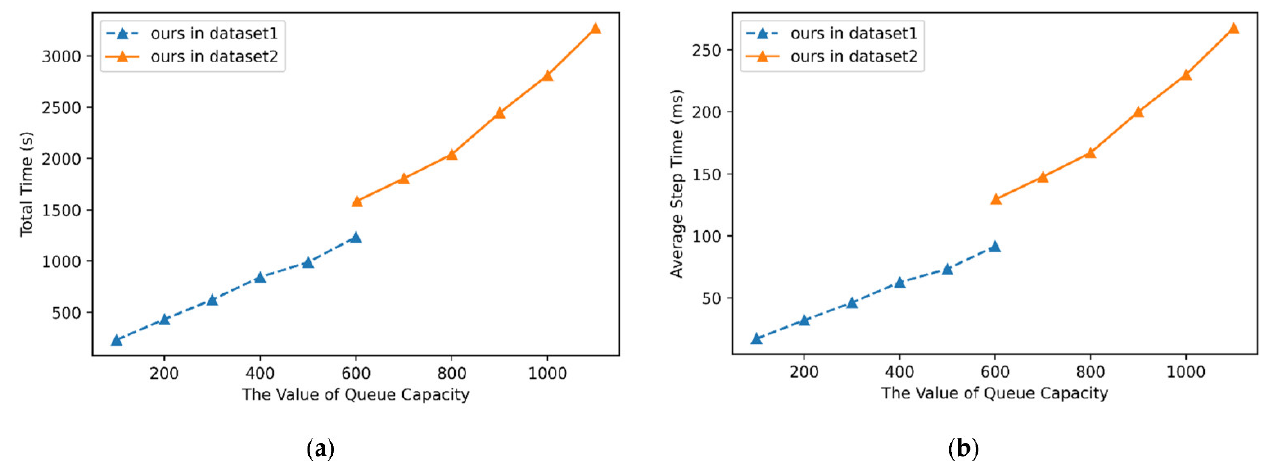
Figure 4. The computing time of ours: ( a ) the total time spent processing all batch data; ( b ) the average step time spent processing a record.